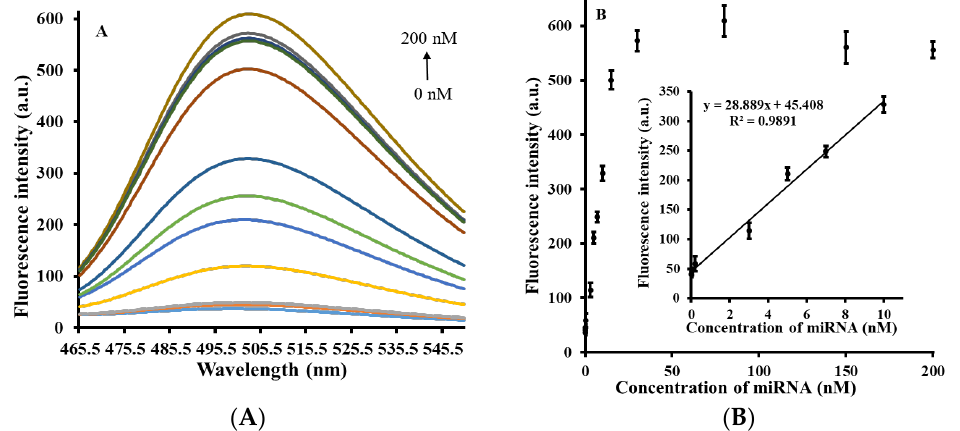
Figure 3. ( A ) Fluorescence emission spectra of the biosensor with different concentrations of miRNA-21 (0, 0.002, 0.02, 3, 5, 7, 10, 15, 30, 80, 150, 200 nM) added. ( B ) Graph of correlation between miRNA-21 concentration and fluorescence intensity. The inset shows that miRNA-21 concentration is linearly correlated with fluorescence intensity at 0.002–10 nM. The error reflects three separate